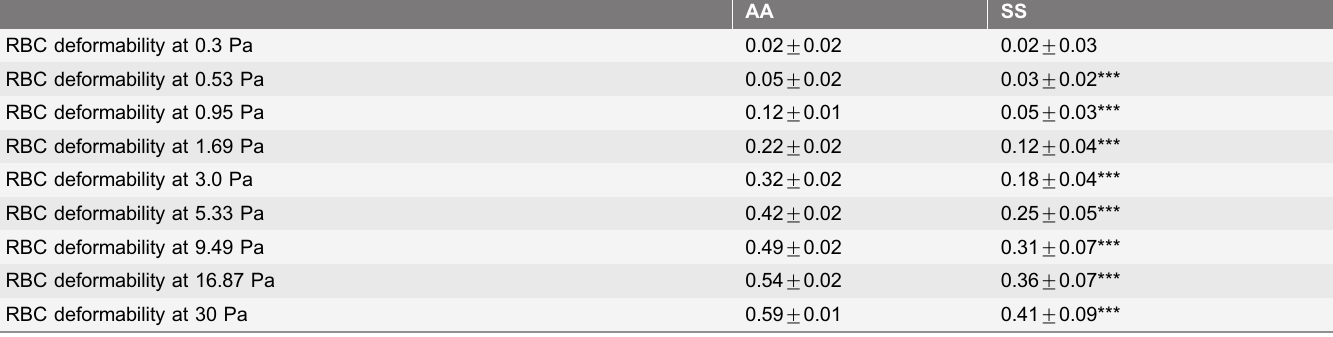
Table 2. Red blood cell (RBC) deformability at different shear stresses in patients with sickle cell anaemia (SS) and healthy individuals